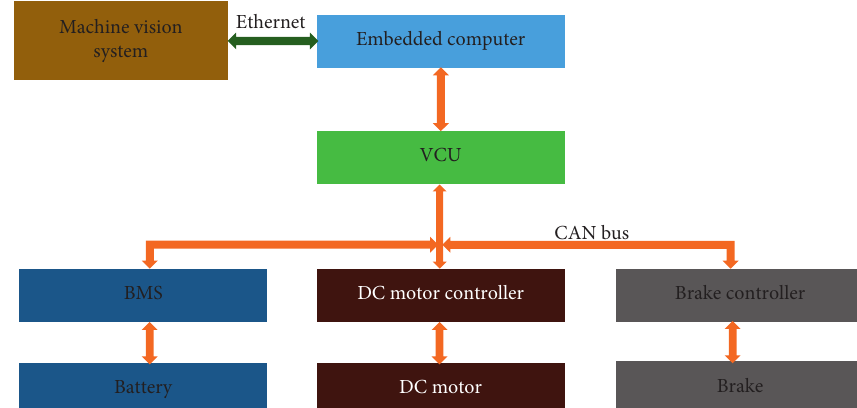
Figure 2: Vehicle control system.